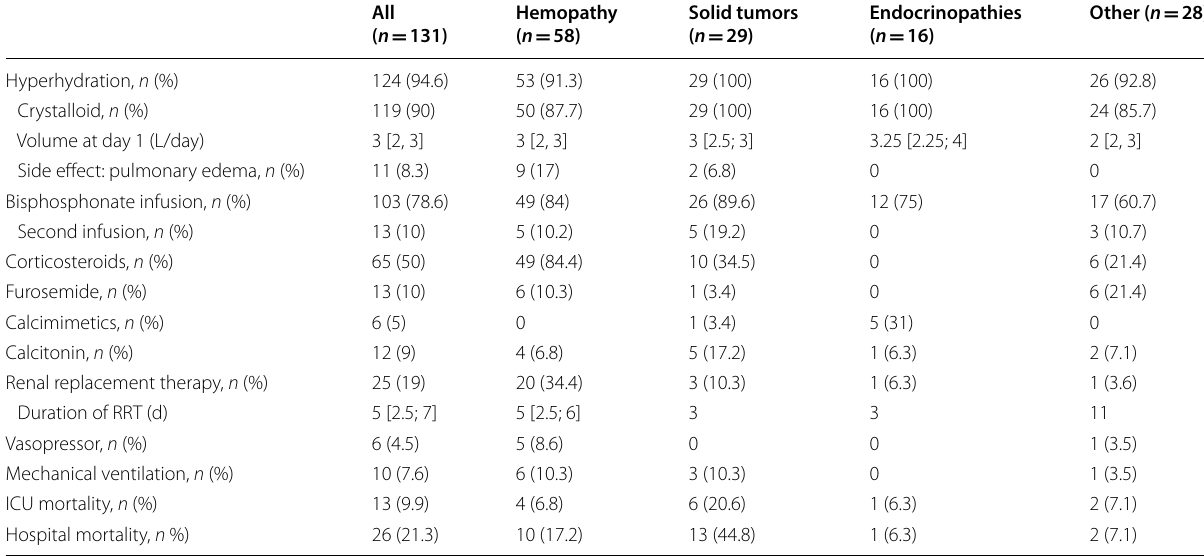
Values for categorical variables are given as number (percentage); values for continuous variables, as median [interquartile range] ICU intensive-care unit, RRT renal replacement